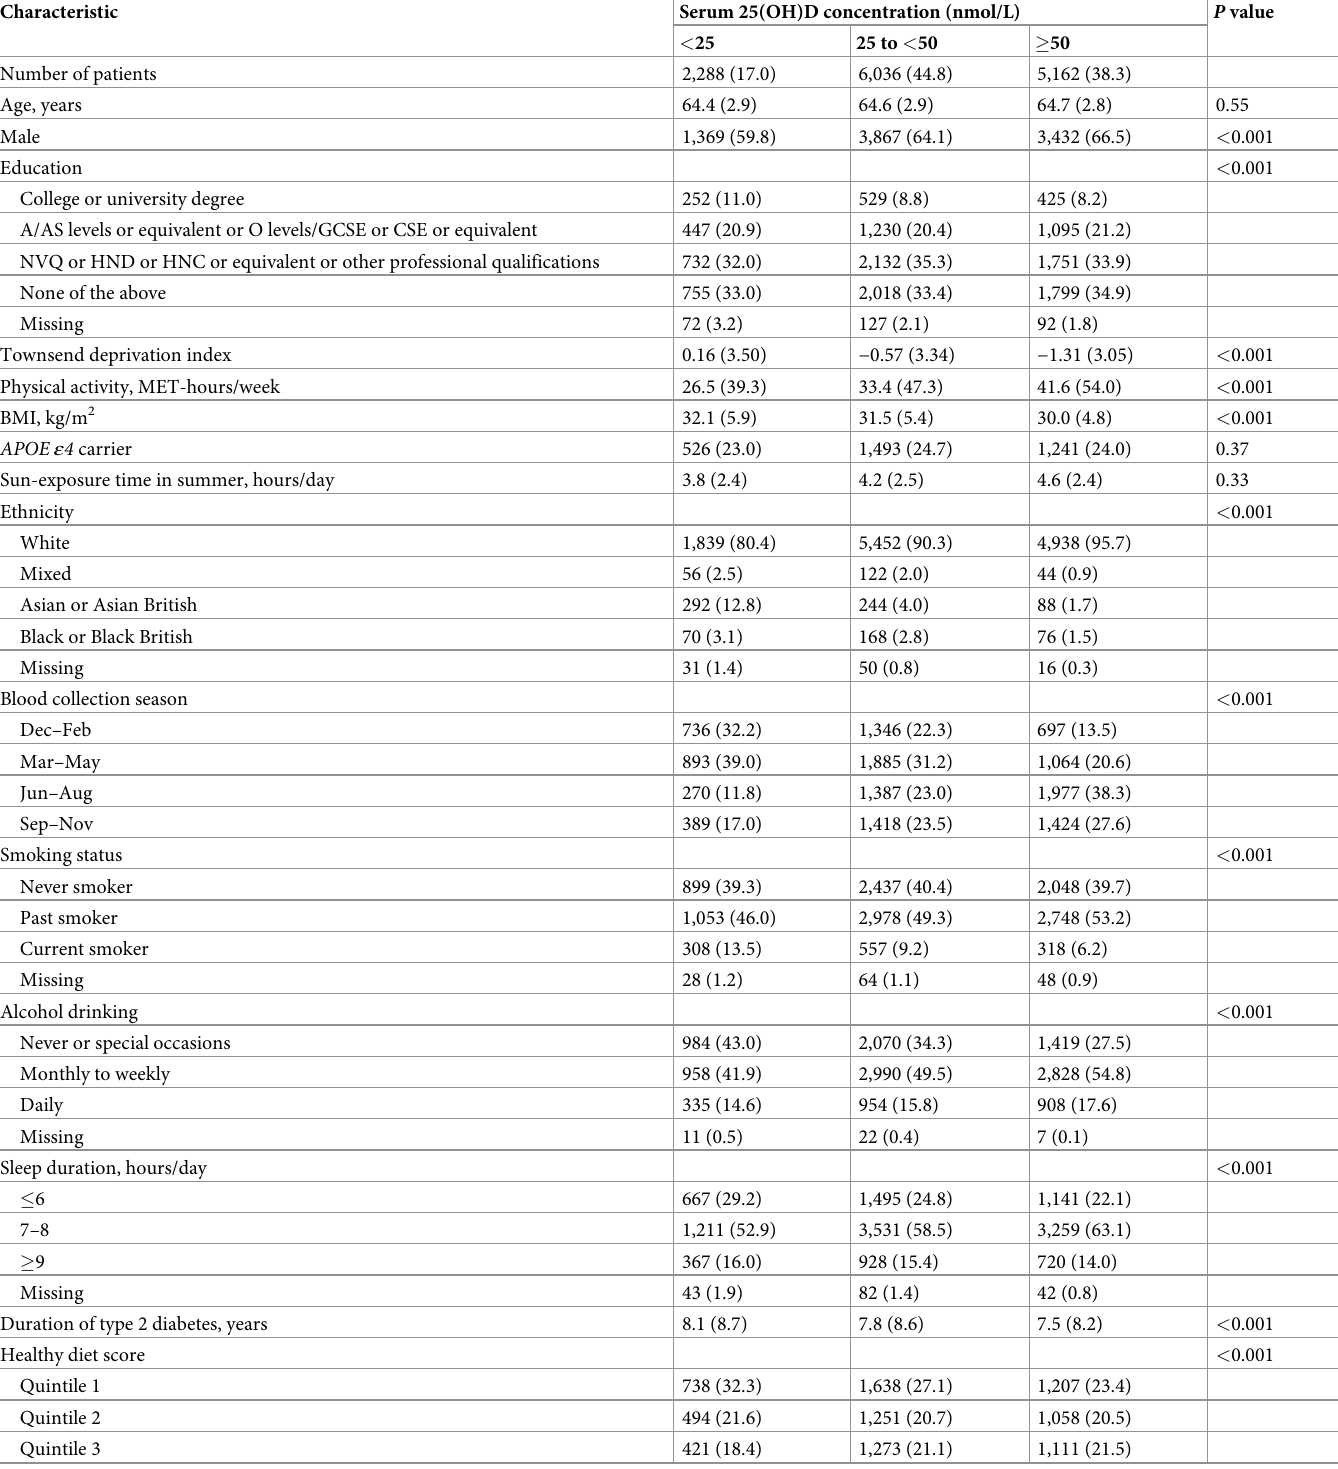
Table 1. Baseline characteristics according to serum 25(OH)D concentrations among individuals with type 2 diabetes who were � 60 years old in the UK Biobank